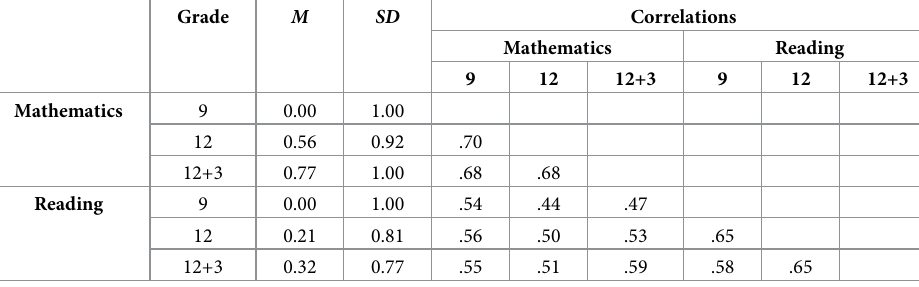
Table 3. Means, standard deviations, and correlations of competence tests.